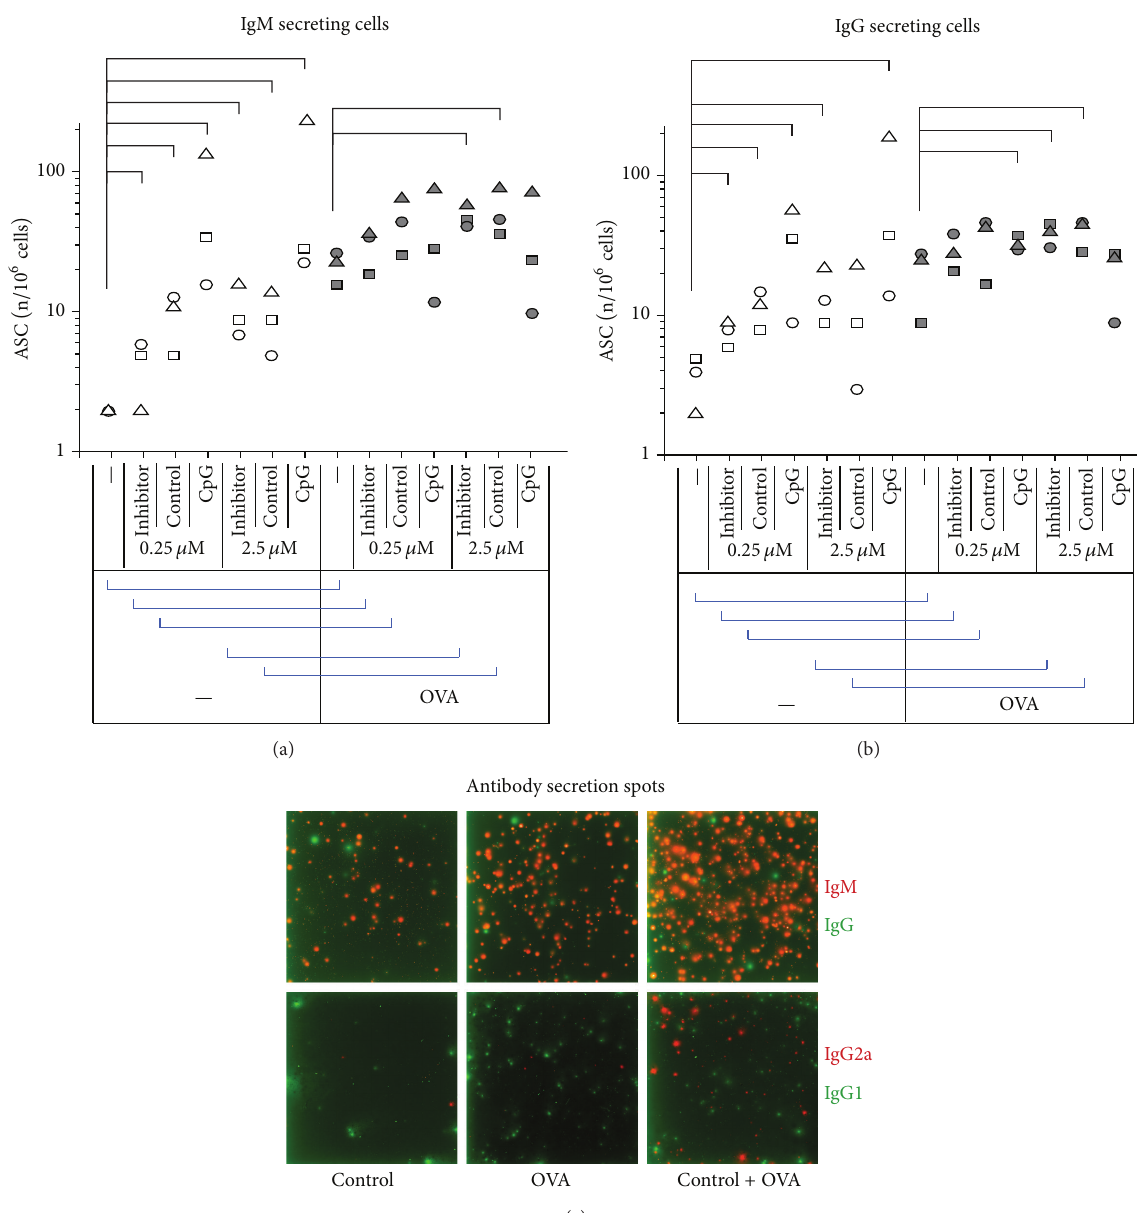
Figure 3: Enhancement of ASC formation by non-CpG ODN. Cells were incubated with the different combinations of ODNs and OVA as indicated; then after 4 days the cultures were transferred onto nitrocellulose-covered slides coated with light chain capture antibodies. After 10 hours of incubation, slides were washed and IgM (a) and IgG (b) spots produced by ASCs were detected using labeled antibodies and a fluorescent scanner. A representative fluorescent spot experiment is shown in (c). Statistical significance was calculated using two-tailed permutation test. Treatment pairs with significant differences ( 𝑃 < 0.05 ) are indicated by connecting brackets; thin lines for within OVA treatment group comparisons and thick lines for OVA treatment effects. ASC: antibody secreting